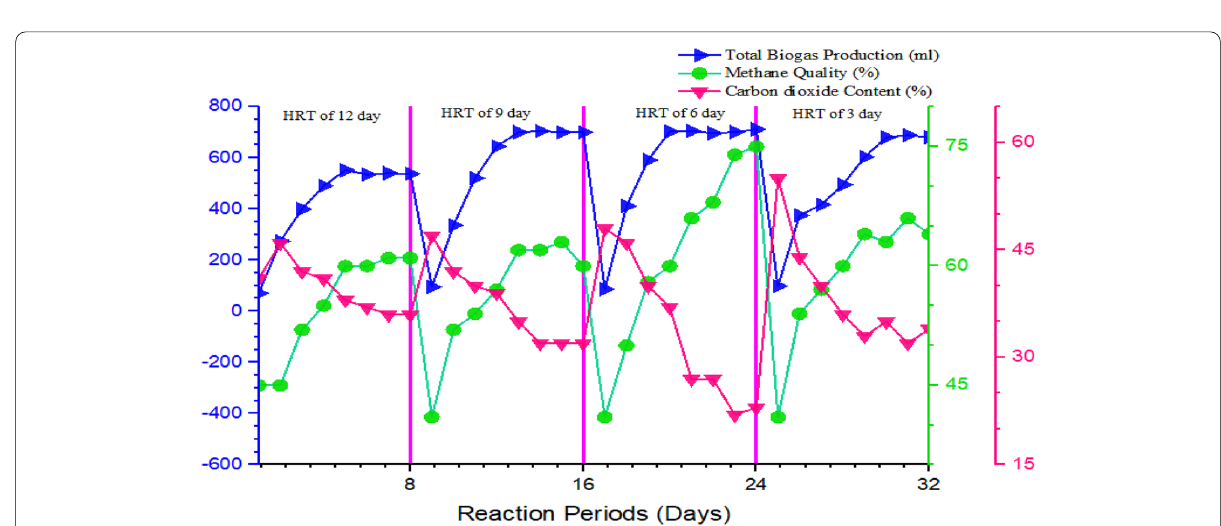
Fig. 8 Variations of biogas production, methane and carbon dioxide percentage of methanogenesis reactor at different